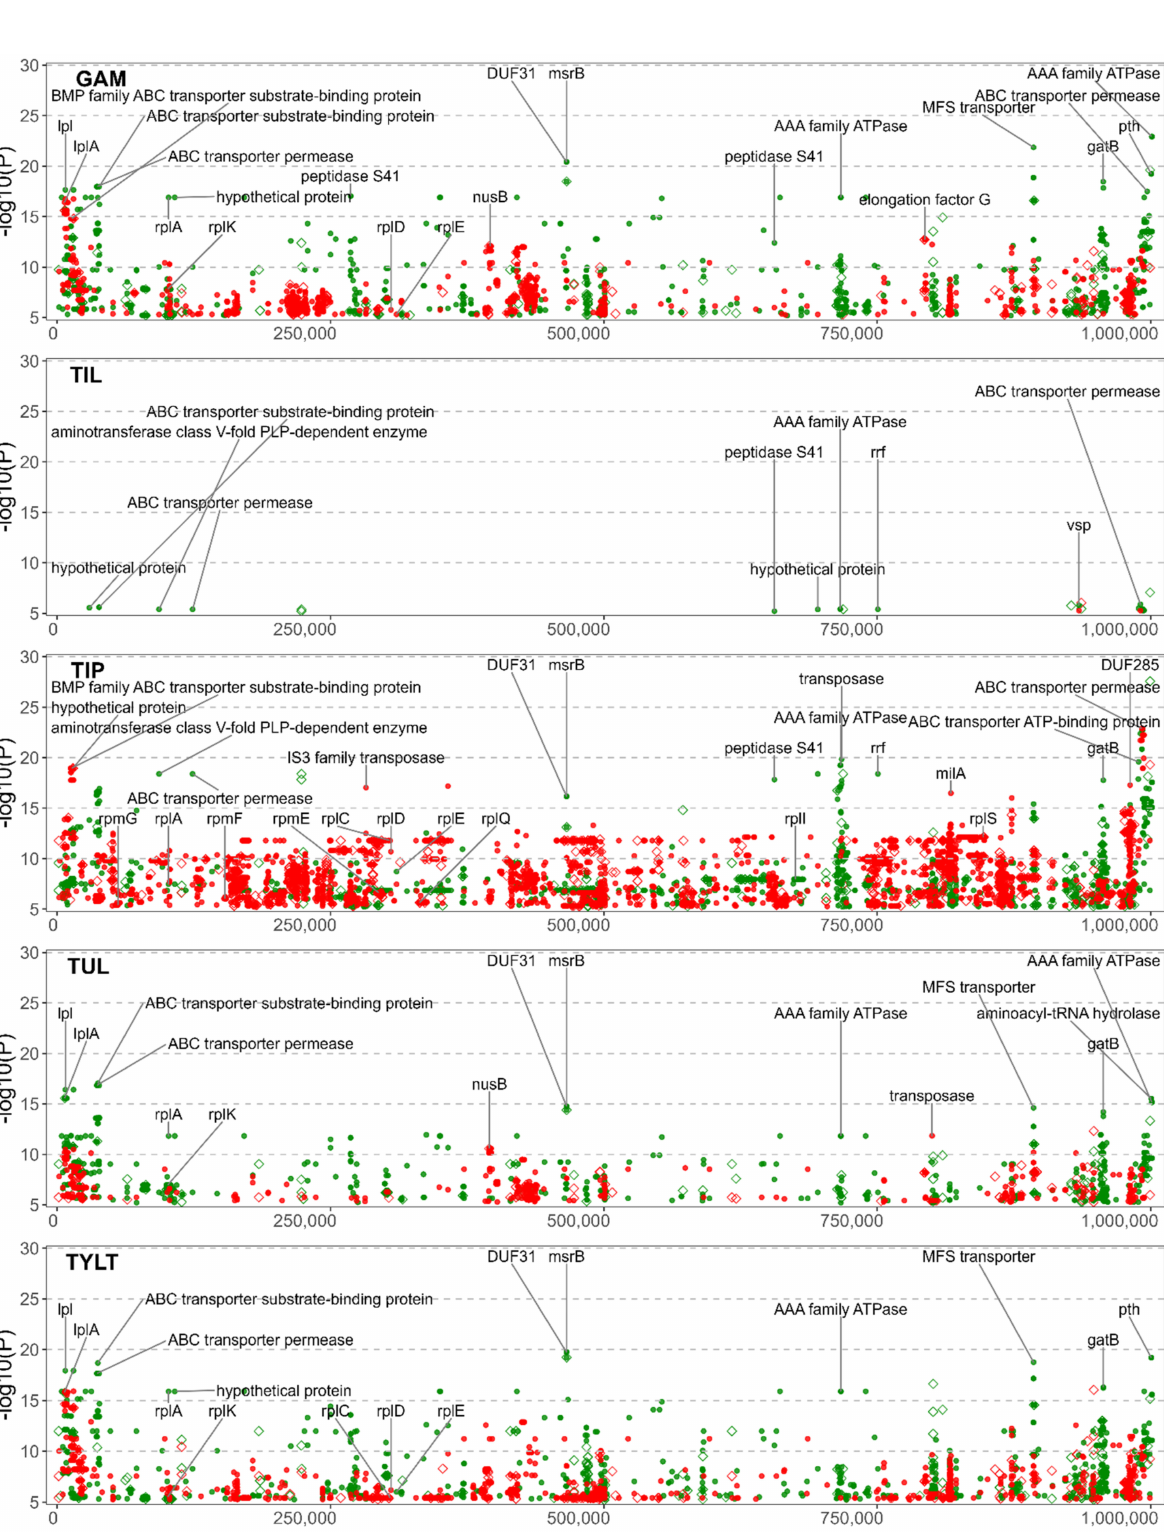
Figure 3. Manhattan plots of variants for gamithromycin, tilmicosin, tildipirosin, tulathromycin, and tylosin tartrate resistance. Variants are colour-coded, with fixed effects linear model (green) and linear mixed model (red). The y -axis represents the level of statistical significance [ − log10 ( p -value)] with position of the nucleotide variant on the x -axis. Significant NVs identified within coding regions are represented with a dot, while significant NVs within non-coding regions are denoted with a hollow